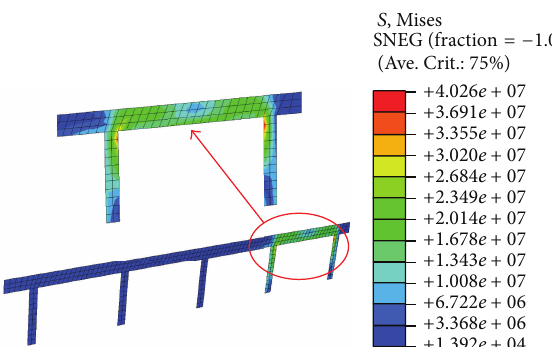
Figure 9: The von Mises stress (Pa) distribution in the supporting columns and girders.